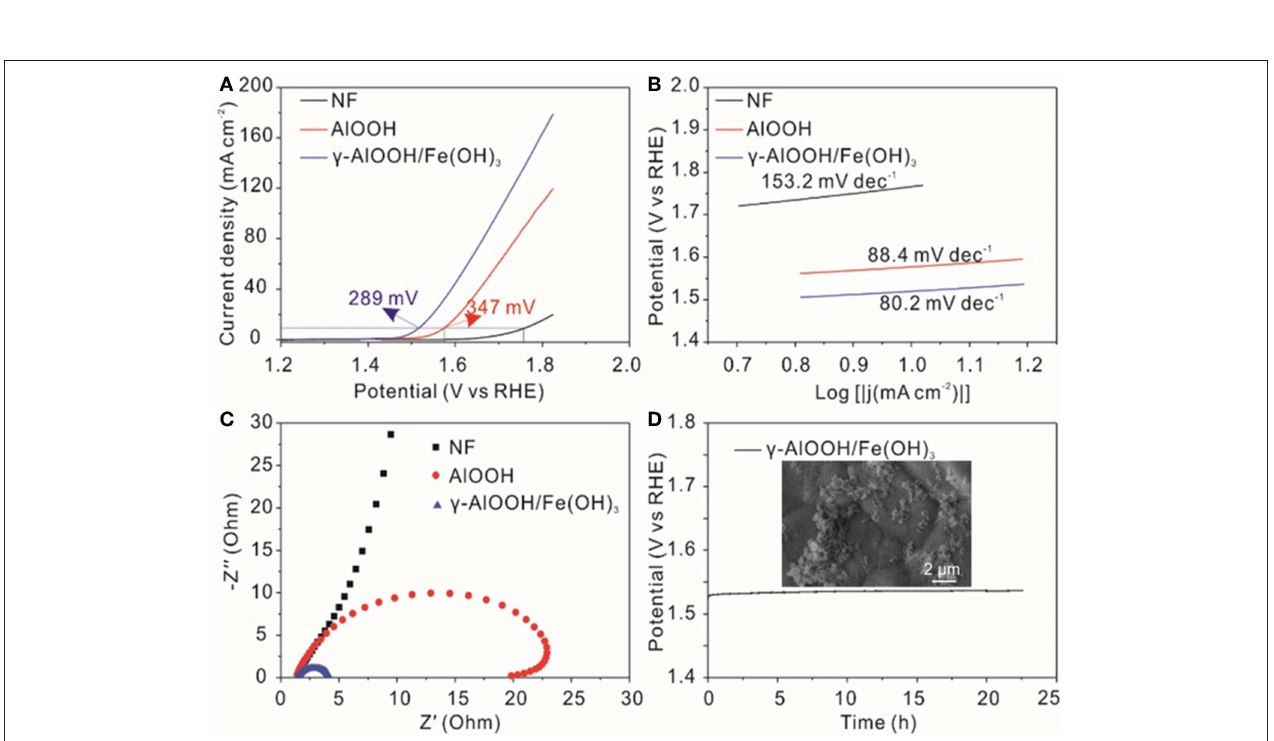
FIGURE 6 | (A) OER polarization curves without iR-compensation, (B) Tafel slopes, (C) Nyquist plots measured at 0.5V vs. Ag/AgCl for various catalysts, and (D) Durability test at 10mA cm − 2 for 22h of γ -AlOOH/Fe(OH) 3 micro/nanoflowers; The SEM image of γ -AlOOH/Fe(OH) 3 after i- t -test(inset).